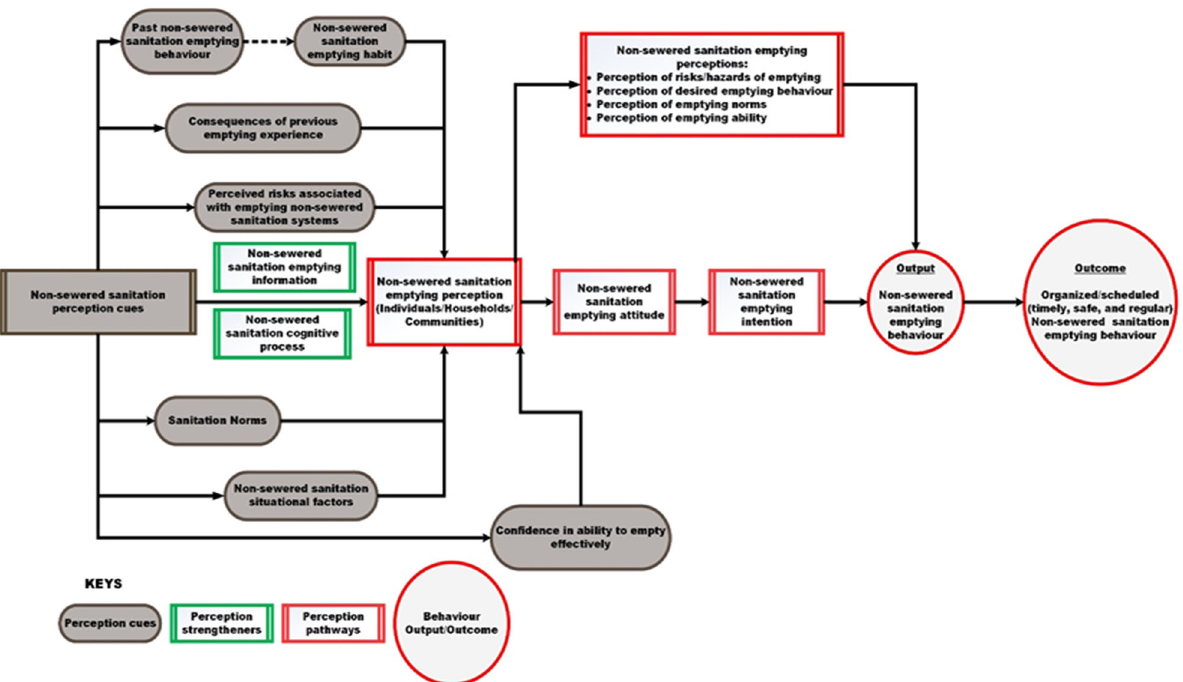
Fig. 1 A non-sewered sanitation emptying perception-behaviour trajectory. It attempts to illustrate perception cues supported by appropriate information and the ability to cognitively process knowledge will create perceptions that lead individuals, households and communities to produce corresponding attitudes, which then determine intentions towards a practice or activities that guide equivalent behaviour (i.e., either to empty or not to empty). It is based on fi ndings of the interlinkages between perception and